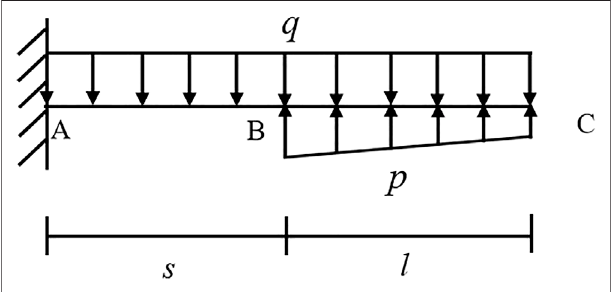
FIGURE 6 | Dig to the end.